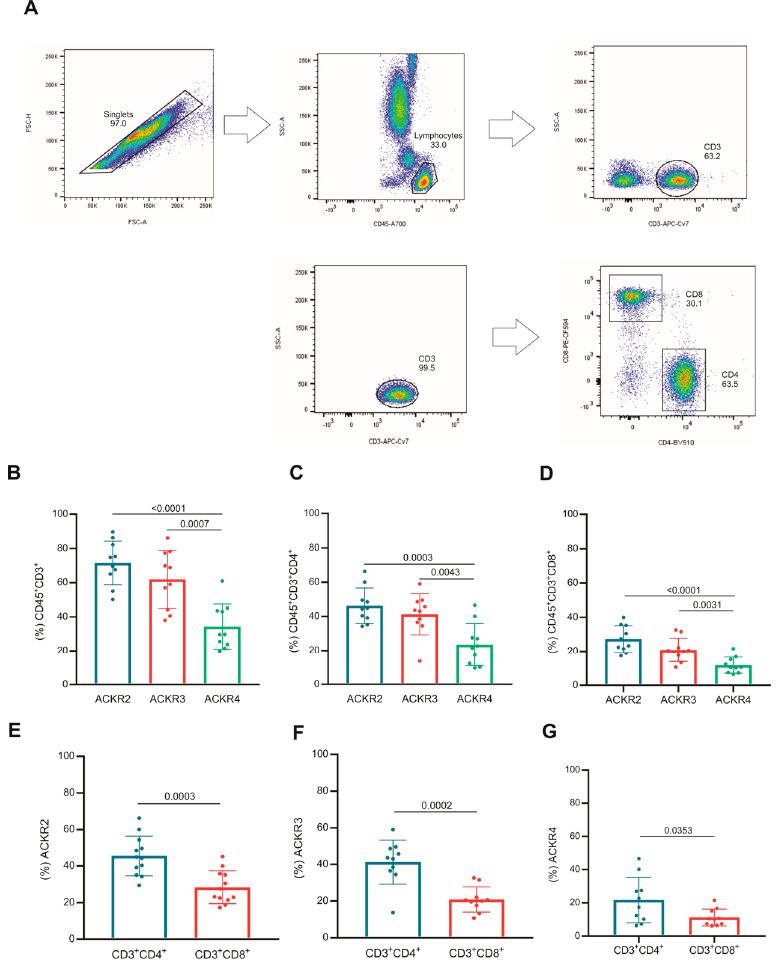
Figure 2. T lymphocytes and subsets that express atypical chemokine receptors ACKR2, ACKR3 and ACKR4. ( A ) Flow cytometry strategy for selection of T lymphocytes was based on their CD45 and CD3 expression, and the T lymphocytes subsets were defined by the expression of CD4 or CD8. ( B ) Expression of ACKR2 (blue), ACKR3 (red) and ACKR4 (green) in populations of CD3 T lymphocytes, ( C ) CD4 T and ( D ) CD8. Expression of ACKR2 ( E ), ACKR3 ( F ) and ACKR4 ( G ) on CD4 (blue) and CD8 (red) T lymphocytes (n = 10).